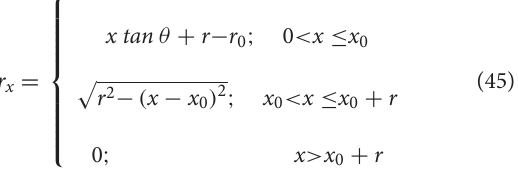
Frontiers in Mechanical Engineering |